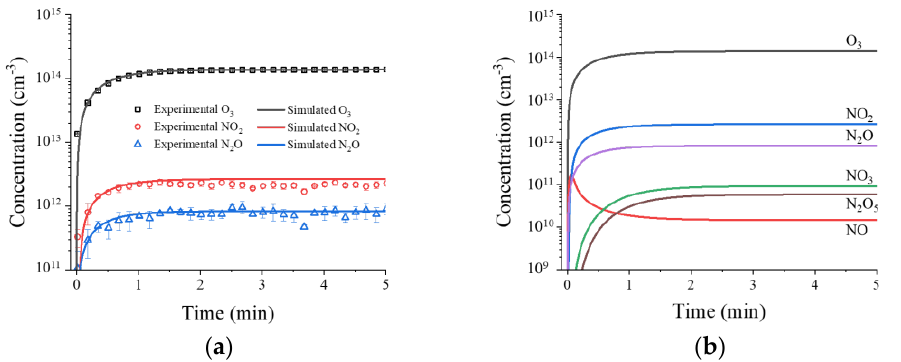
Figure 3. ( a ) Experimental and simulated results of O 3 , NO, and N 2 O versus time and ( b ) chemical species in 0D chemical simulation.